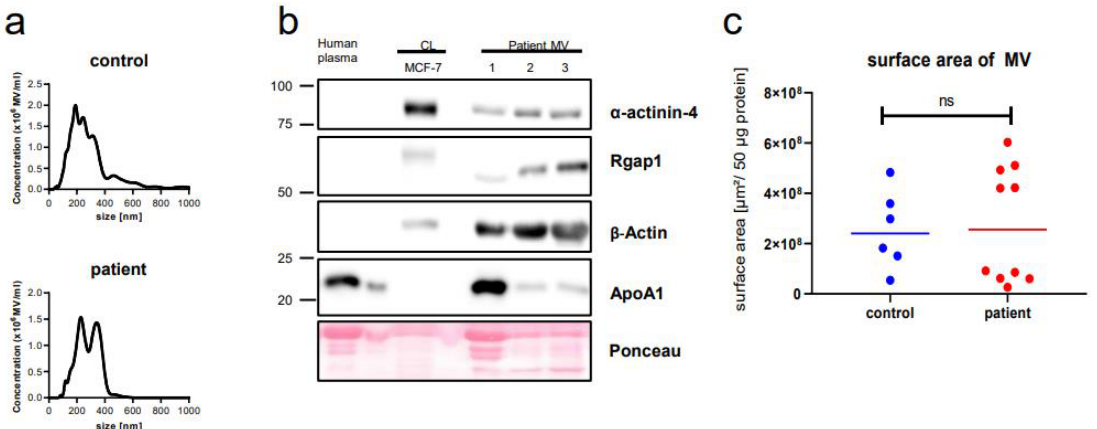
Figure 1. Characterization of plasma microvesicles (MV). MV of the controls and breast cancer patients show a similar concentration and distribution in size ( a ); ( b ) representative Western blot of three independent MV patient samples for common vesicle markers; and ( c ) MV of patients and controls show a similar surface area per 50 µg protein: mean surface was 2.77 × 10 8 µm 2 (SD ± 2.30 × 10 8 µm 2 ) and of 2.55 × 10 8 µm 2 (SD ± 1.56 × 10 8 µm 2 ) for patients and healthy controls, respectively. CL = whole cell lysate from MCF-7 cells. Table 1. Clinical characteristics of the patients and healthy controls.